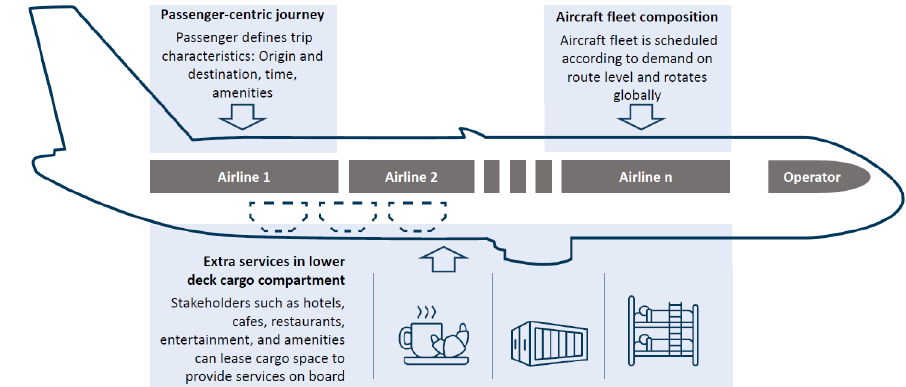
5. Conceptual representation of the Seat sharing concept proving transport capacity